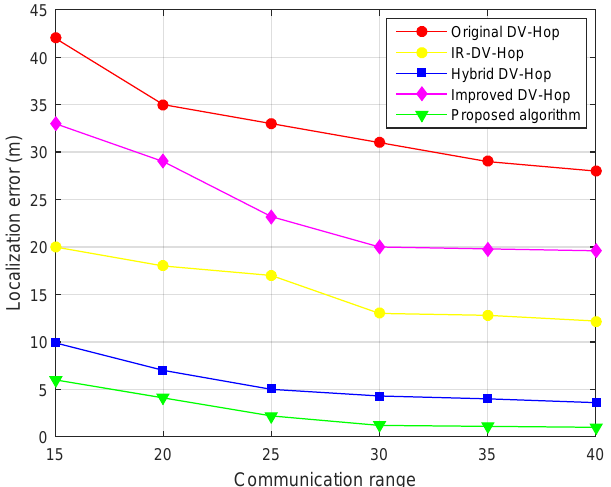
Figure 9. Localization error as function of transmission range, with 100 sensor nodes and ratio of anchors =